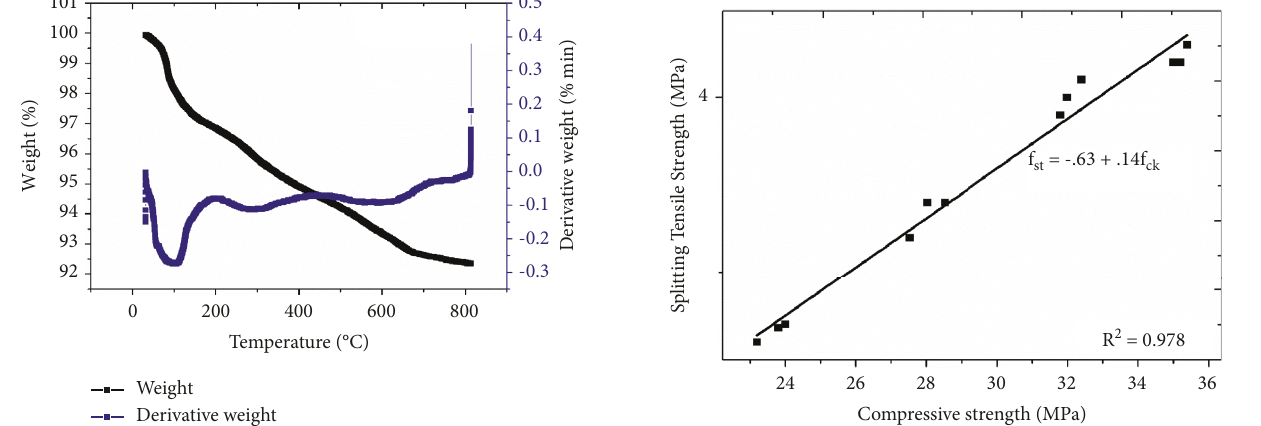
Figure 8: Graph of TGA-DTG test of GPC mix. Figure 9: Graph of correlation between compressive strength and splitting